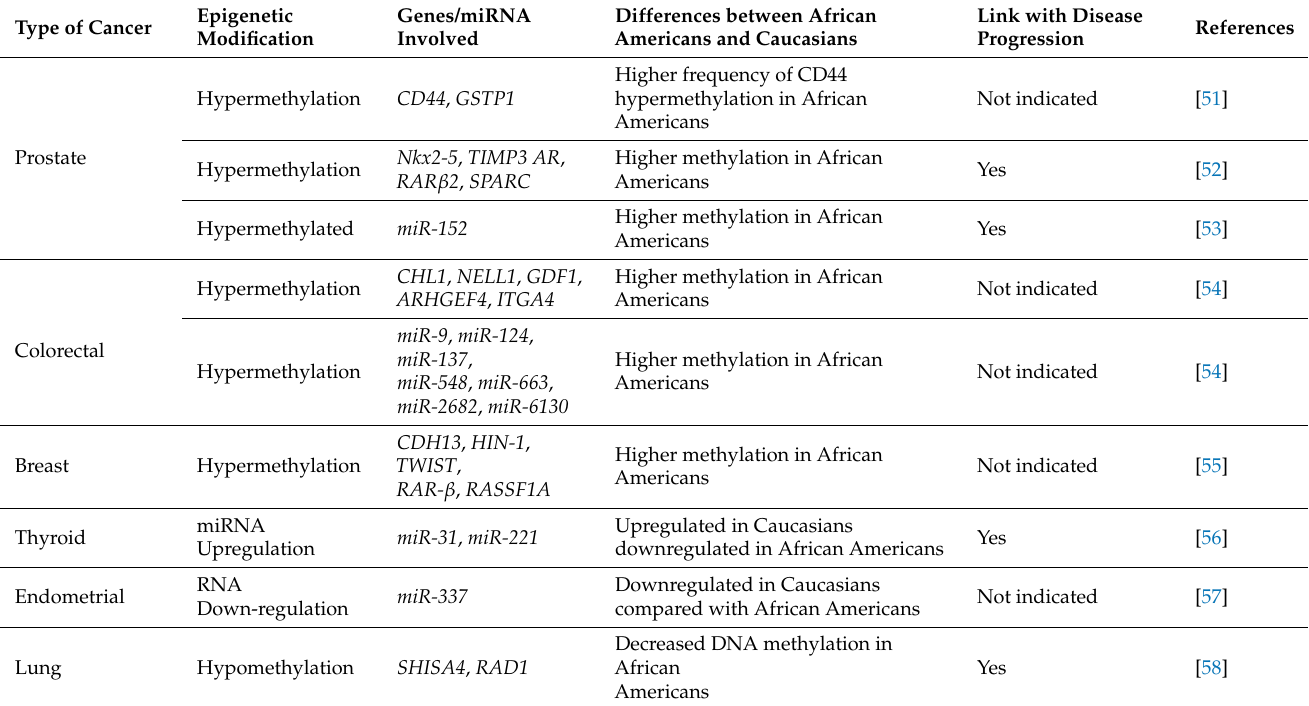
Table 1. Epigenetic modifications in African Americans and the genes